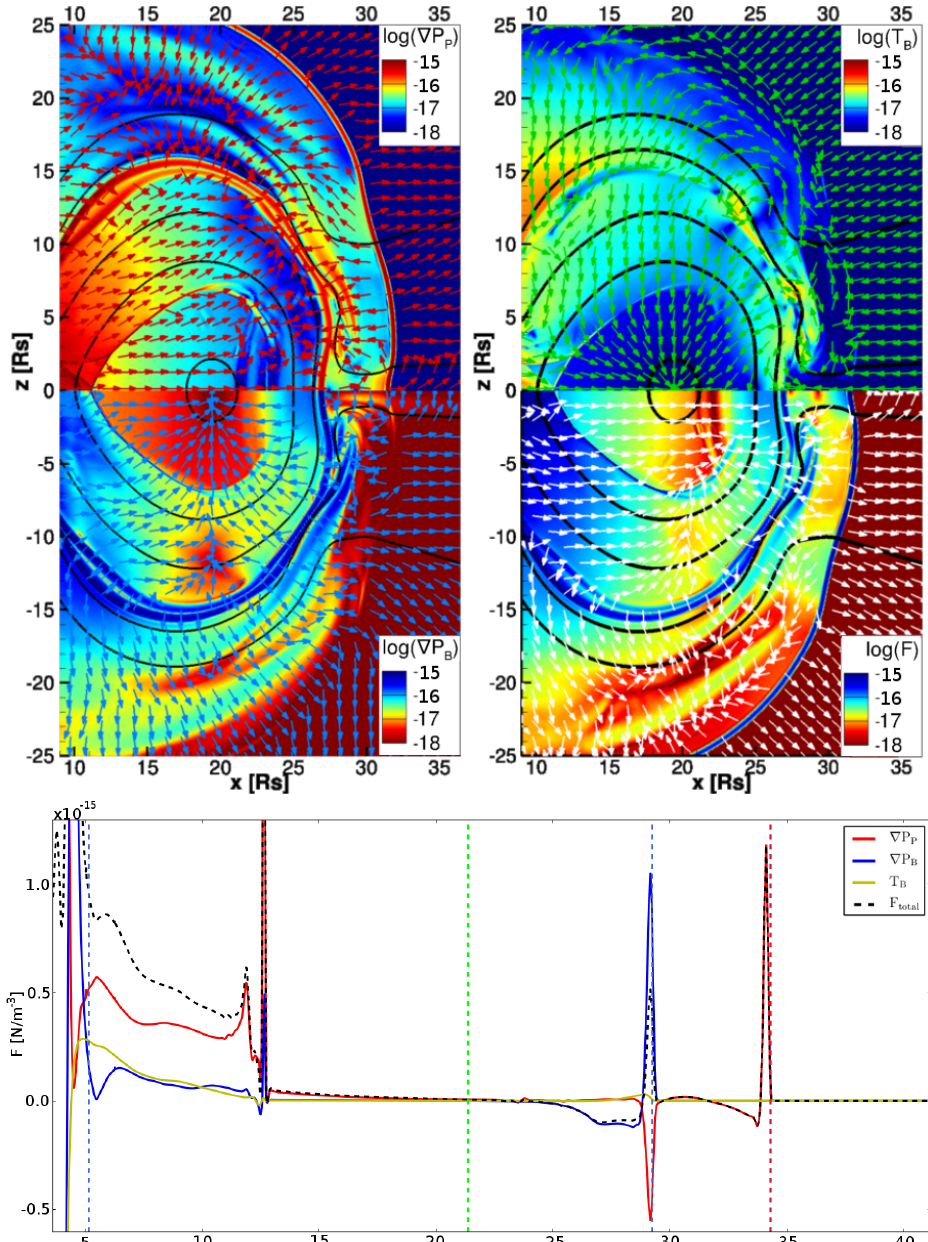
Figure 2. Upper: Forces that govern the CME dynamics five hours after ejection of a normal medium velocity CME in a middle density background wind. Each plot is split into the upper and lower half of the CME showing a different force, with the colour contours representing the magnitude of the force and the vectors the direction. For clarity, colour bars have been flipped between upper and lower panels. The left figure shows ∇ P p and ∇ P B in the upper and lower half, respectively. The right figure shows T B and the resultant force in the upper and lower half, respectively. Lower: Radial cut in the equatorial plane. The red, blue and green dotted vertical lines represent the positions of the shock, magnetic cloud boundaries and magnetic cloud centre,